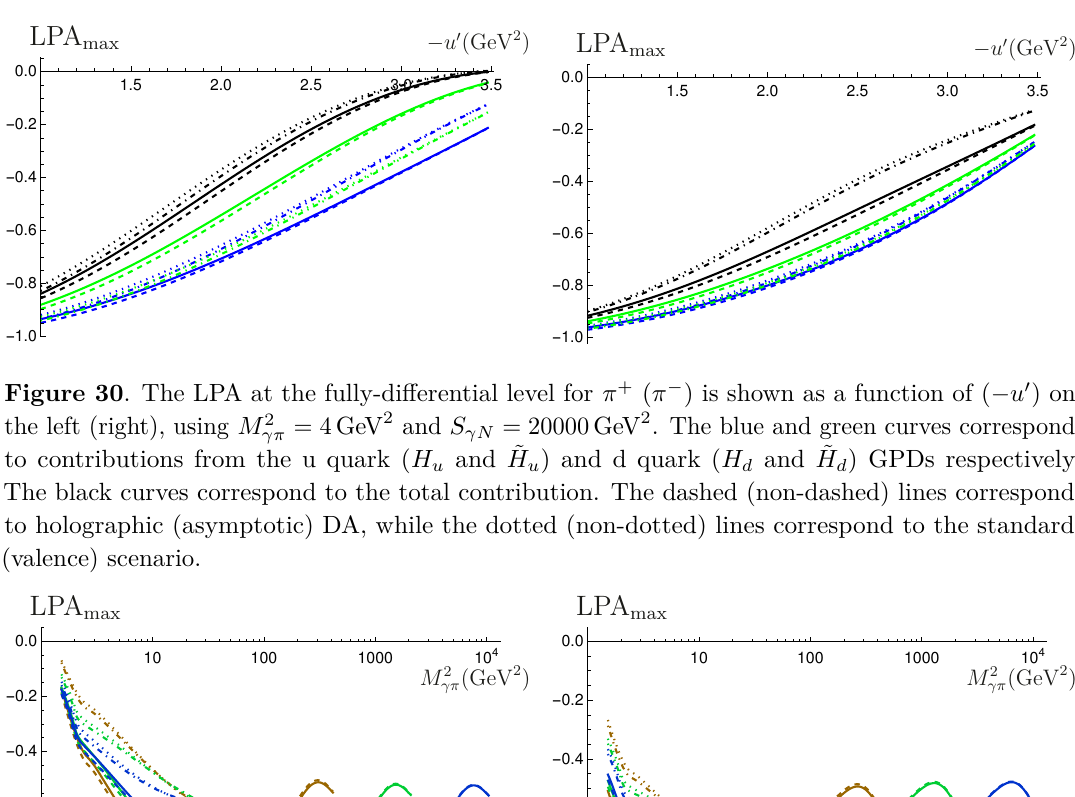
Figure 31 . The LPA at the single differential level for π + ( π − ) is shown as a function of M 2 left (right). The brown, green and blue curves correspond to S dashed (non-dashed) lines correspond to holographic (asymptotic) DA, while the dotted (non-dotted) lines correspond to the standard (valence) scenario. As was the case in figure 21, we note that the choice of the GPD model (valence or standard) gives a completely different shape for the LPA, whereas the model for the DA has minimal effect. Note that a log scale is used for the horizontal axis.